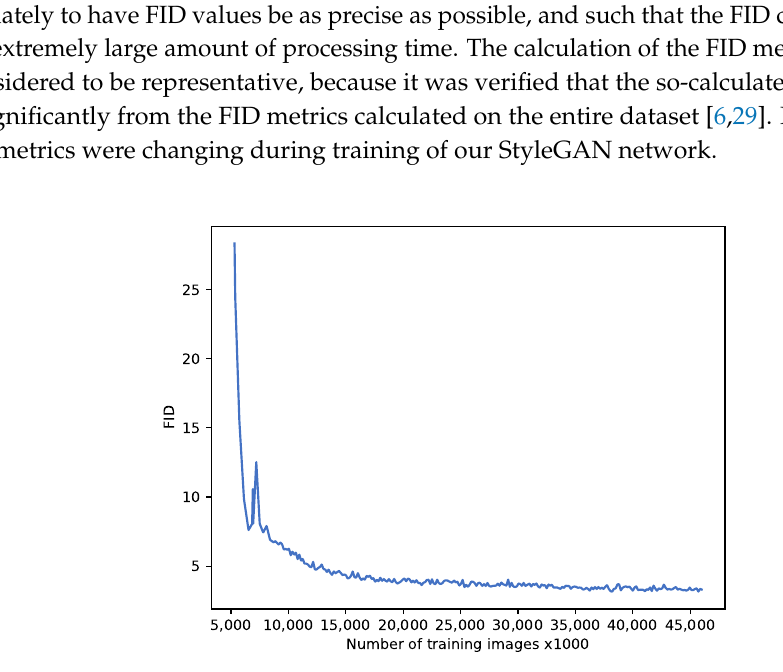
Figure 8. Change of FID metrics during training of the StyleGAN network. The proposed LSUN-Stanford car dataset was used. Axis x denotes the number of training images seen by the discriminator of the StyleGAN network. Some unstable behaviour can be noticed between 7M and 9M training images, which is a consequence of significant changes in the images‘ resolution and properties of the